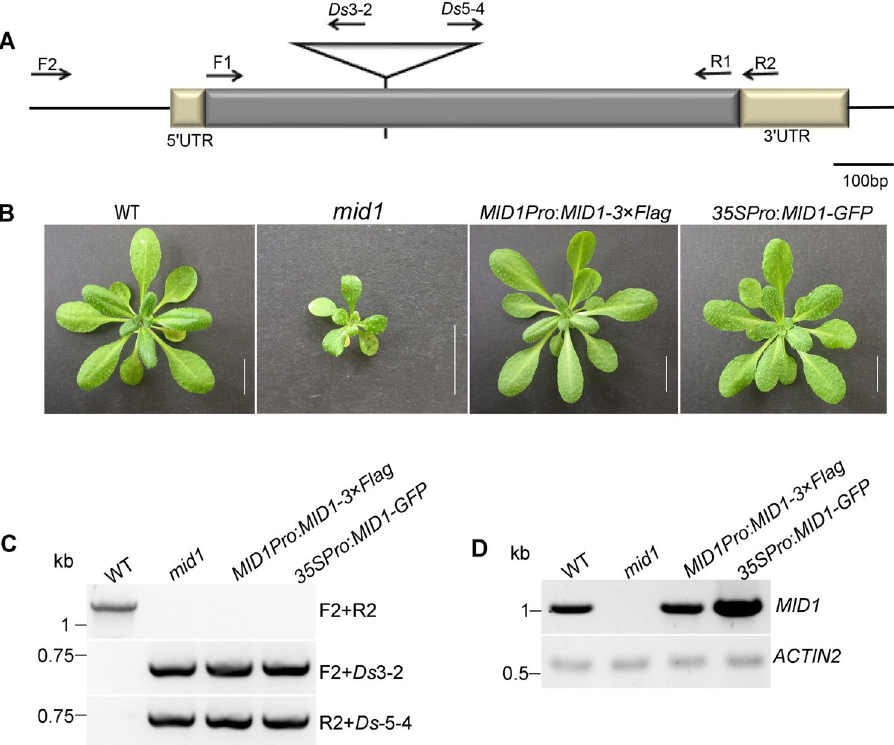
Figure 3. Cloning of MID1 . ( A ) Diagram of mid1 mutant. The Ds insertion is pointed out by a triangle. The position of primers used in ( C , D ) are displayed by arrows. ( B ) The phenotype of 4-week-old wild-type (WT), mid1 , and genetically complemented lines MID1Pro : MID1 - 3 × Flag and 35SPro : MID1 - GFP . Bar = 1 cm. ( C ) Genotyping of plants in ( B ) using the primers indicated in ( A ). ( D ) RT-PCR detection of MID1 cDNA in plants ( B ) to confirm the successful complementation. The primers F1 and R1 were used to RT-PCR analysis of MID1